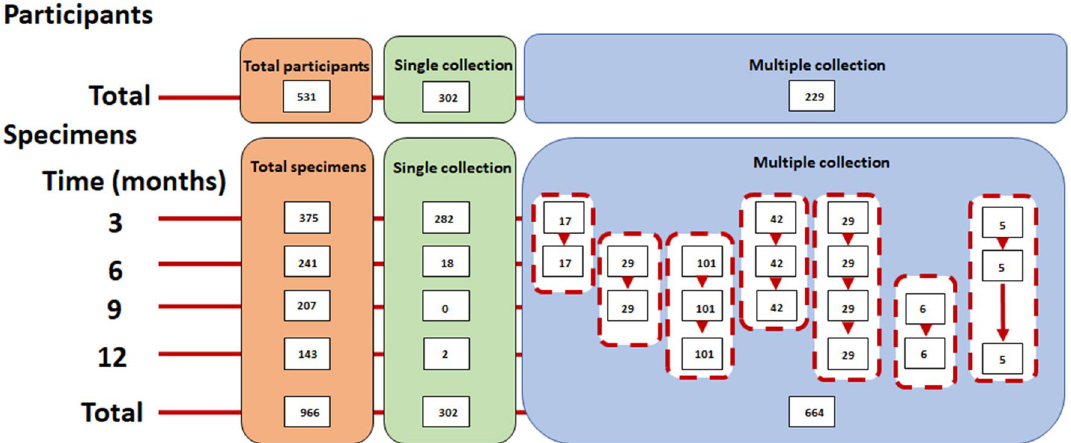
Figure 6. Flow diagram of participant recruitment and specimen collection in this study. A total of 531 participants were enrolled; 302 provided a blood sample at a single time point and 229 provided multiple